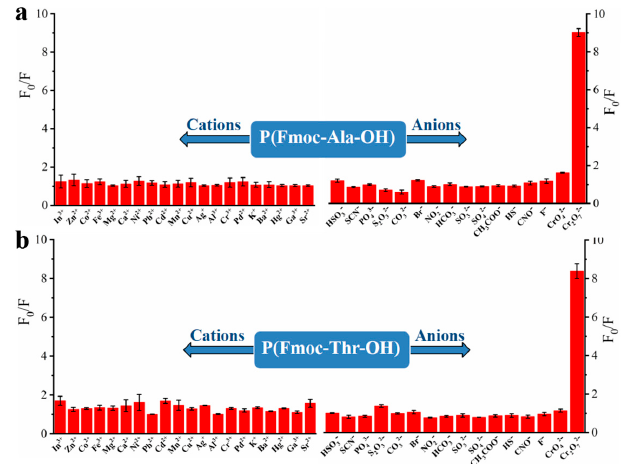
Figure 4. Fluorescence quenching of P(Fmoc-Ala-OH) ( a ) and P(Fmoc-Thr-OH) ( b ) to various cations/anions.